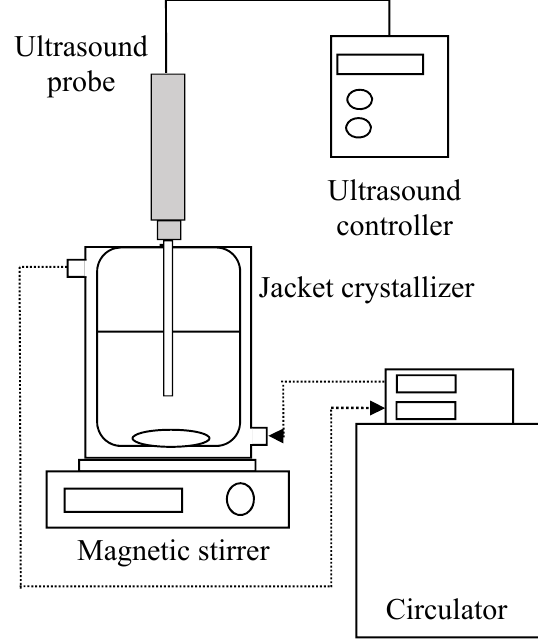
Figure 1. Experimental apparatus for sonocrystallization.